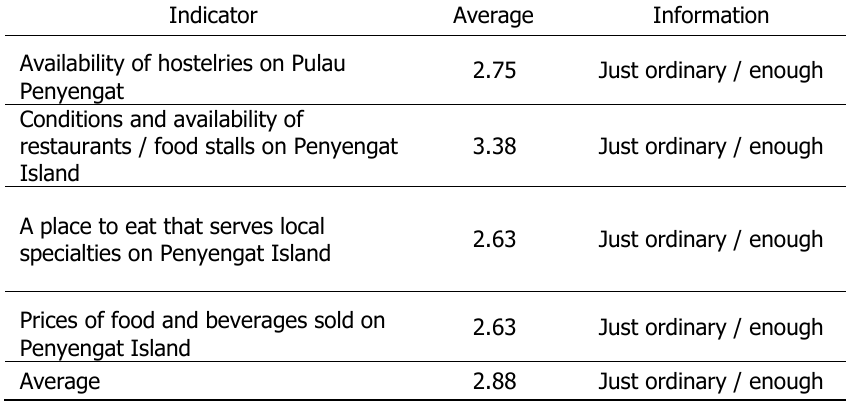
Table 6. Assessment indicators for accommodation